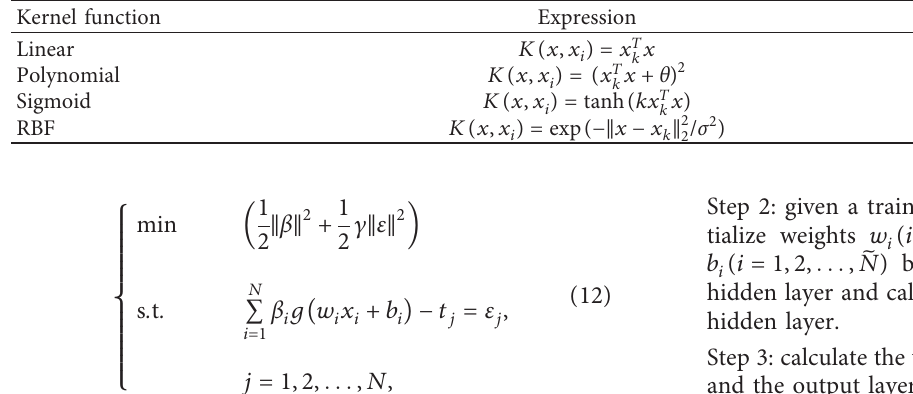
Table 1: Kernel functions used by